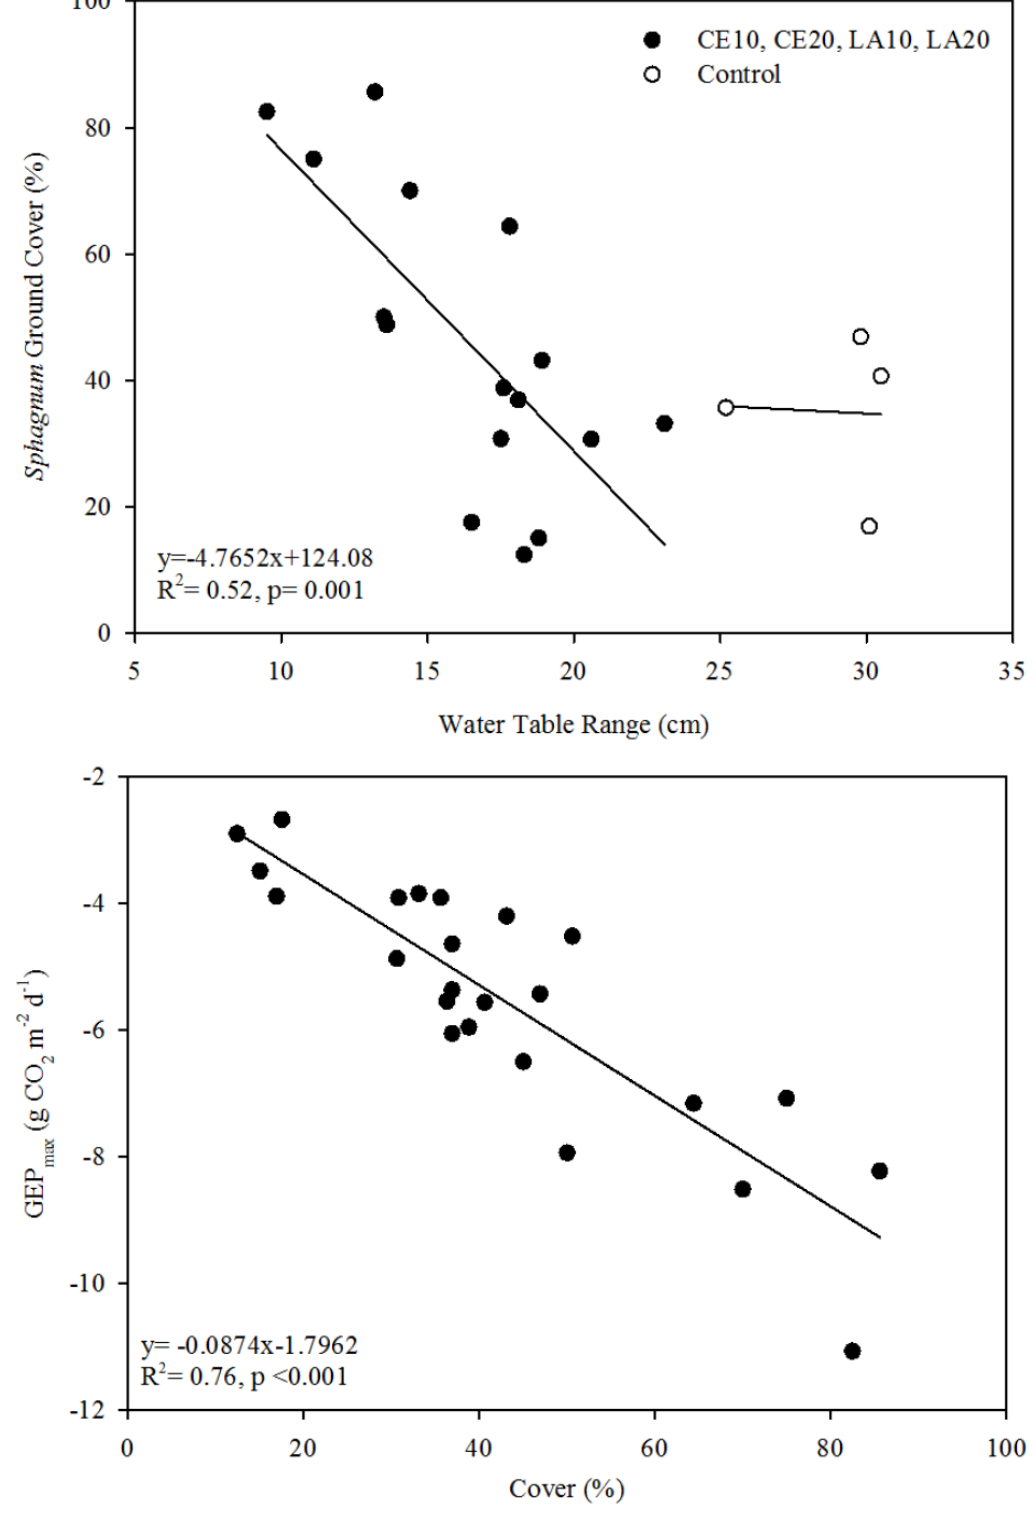
Figure 2. Control of WT range on Sphagnum ground cover (a) and the relationship between Sphagnum ground cover and gross ecosystem photosynthesis (GEP) when photon flux density of photosynthesis was greater than 1000 µmol m -2 s -1 (GEP ) (b). Filled symbols show data from the plots within the actively max managed basins excluding